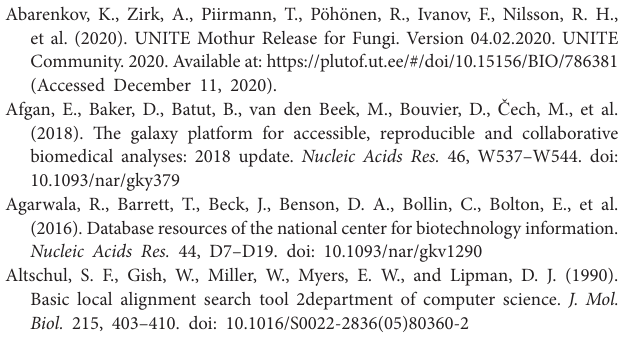
Supplementary Table S25 | Results from BLASTn of the fungal unclassified OTUs associated with sponge species (A) and summary of the taxonomic distribution of the unclassified OTUs (B) Ac: Aplysina caissara , Af: Aplysina fulva . Supplementary Table S26 | Stochastic ratio of fungi community assembly estimated by modified stochasticity ratio (MST) analysis with Bray–Curtis dissimilarity distance (A) and Sloan null hypothesis of fungal community assembly (B) . Ac: Aplysina caissara , Af: Aplysina fulva , SW: seawater, SD: sediment. Supplementary Table S27 | Fungal taxonomic composition of OTUs obtained exclusively in Aplysina caissara (A) , Aplysina fulva (B) , Aplysina species (C) , seawater (D) , sediment (E) , and the core of all categories (F) . Supplementary Table S28 | List of enhanced features provided by linear discriminant analysis (LDA) of effect size LEfSe that are differential across sponge species, seawater, and sediment with statistical and biological significance, and ranked according to the effect size (LDA) for the whole fungal (A) , for habitat generalist fungal (B) , and for habitat specialist (C) groups. Supplementary Table S29 | OTUs vs. samples table containing all categories and OTU taxonomic assignments for the unicellular eukaryotes dataset. Supplementary Table S30 | Unicellular eukaryotic community composition of the habitat generalist group (A) and habitat specialist group (B) . Ac: Aplysina caissara , Ti: Tedania ignis , SW: seawater, SD: sediment. Supplementary Table S31 | Relative abundance of the unicellular eukaryotic composition for phylum (A) and class (B) . Ac: Aplysina caissara , Ti: Tedania ignis , SW: seawater, SD: sediment. Supplementary Table S32 | Results from BLASTn of the unicellular eukaryotic unclassified OTUs associated with sponge species (A) and summary of the taxonomic distribution of the unclassified OTUs (B) . Ac: Aplysina caissara , Ti: Tedania ignis . Supplementary Table S33 | Stochastic ratio of unicellular eukaryotic community assembly estimated by modified stochasticity ratio (MST) analysis with Bray–Curtis dissimilarity distance (A) and Sloan null hypothesis of unicellular eukaryotic community assembly (B) . Ac: Aplysina caissara , Af: Aplysina fulva , SW: seawater, SD: sediment. Supplementary Table S35 | List of enhanced features provided by linear discriminant analysis (LDA) of effect size LEfSe that are differential across sponge species, seawater, and sediment with statistical and biological significance, and ranked according to the effect size (LDA) for the whole unicellular eukaryotic (A) and for habitat specialist unicellular eukaryotic (B)